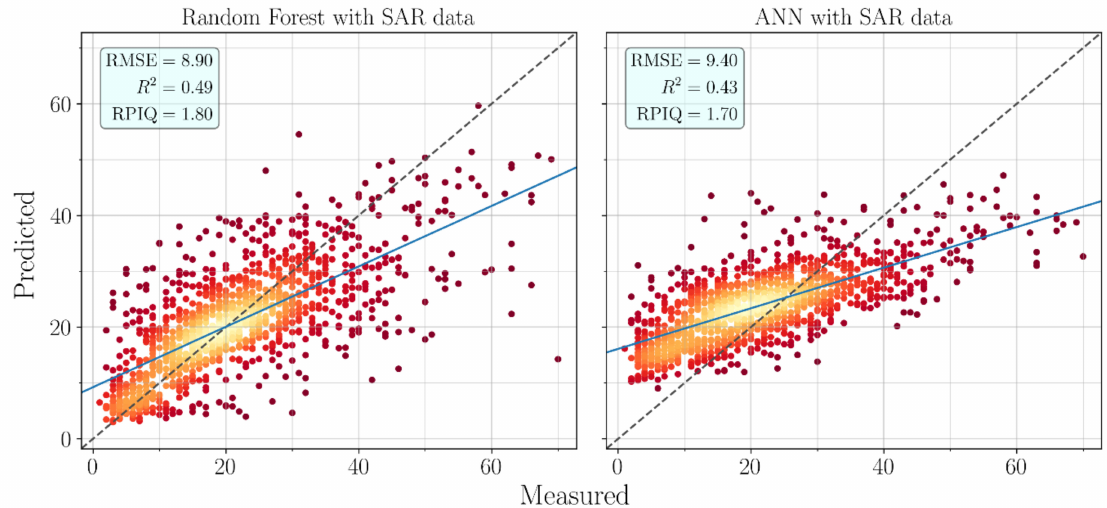
Figure A1. Goodness of fit indicating the relationship between observed and predicted clay content based on the RF and ANN model using the complete set of available features for all the timesteps. The plotting values represent the mean value of the predicted